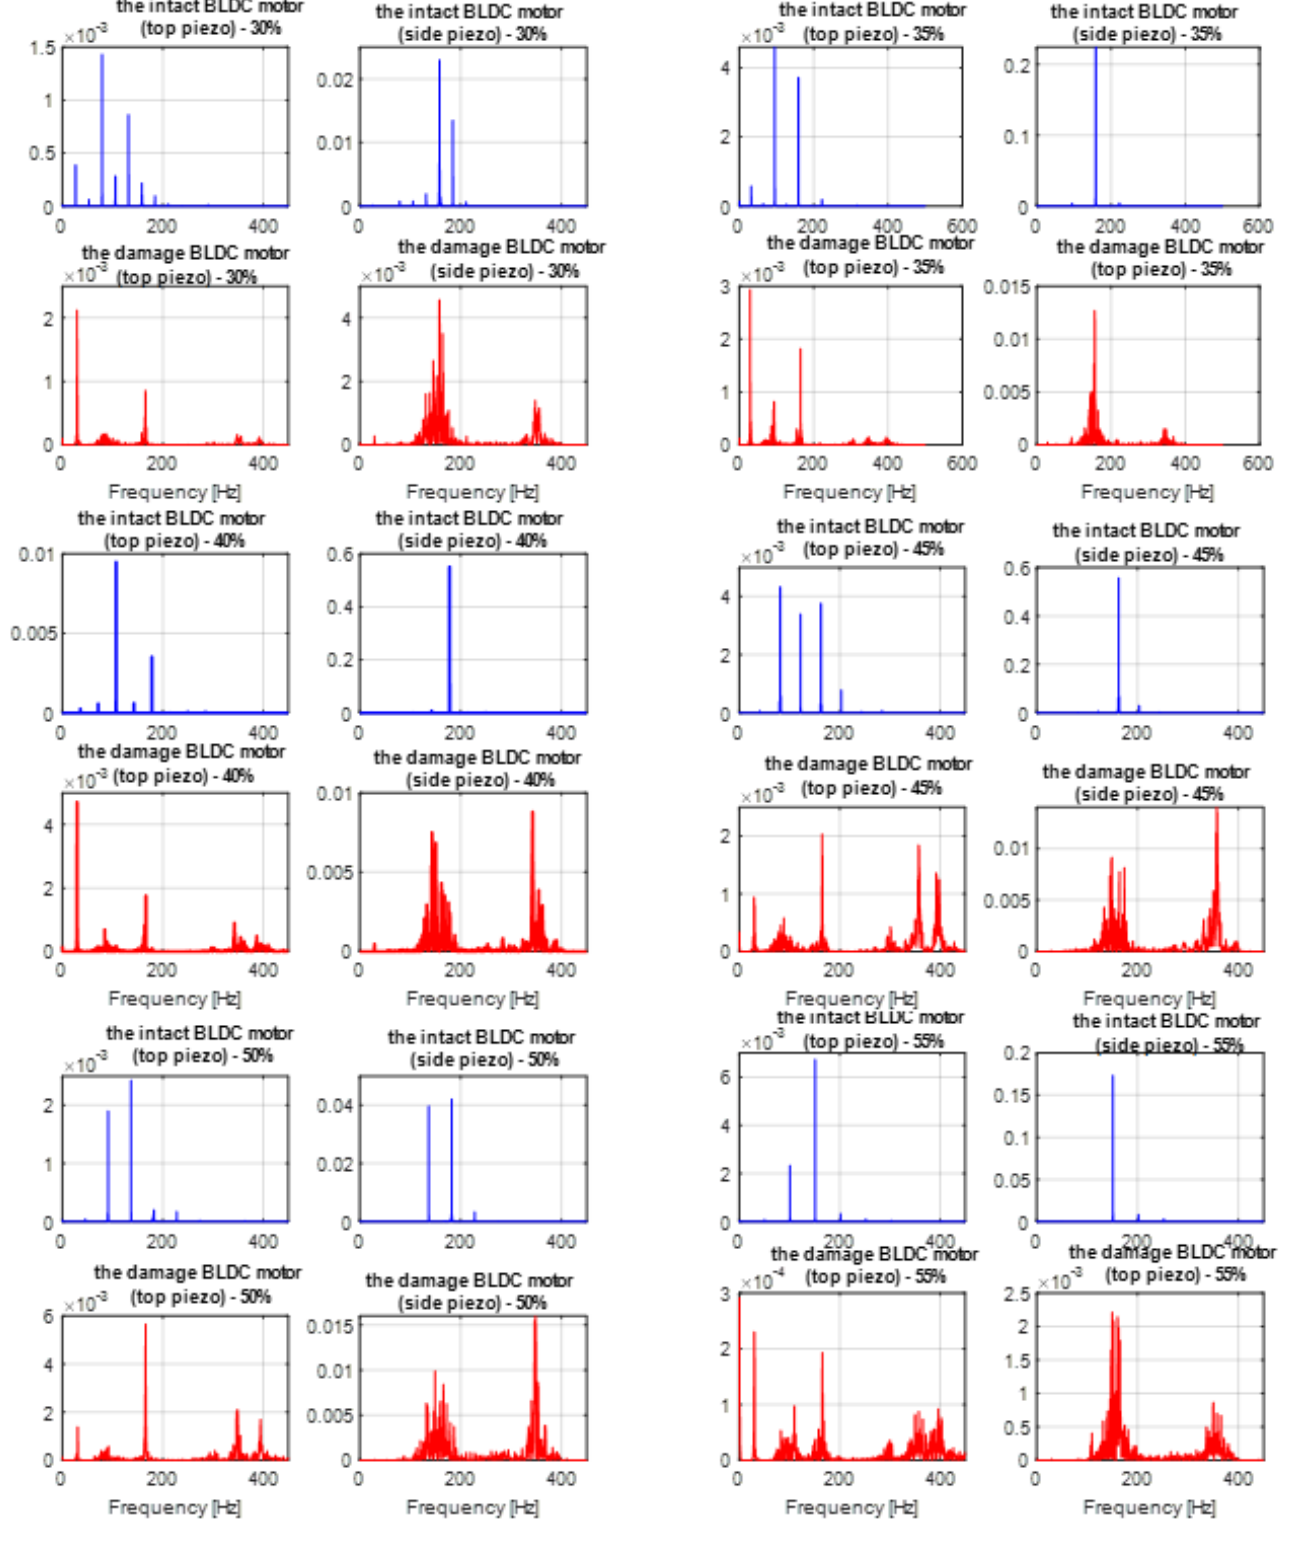
Figure 13. Frequency corresponding to voltage time series in Figure 12 for different values of the duty cycle of PWM signal applying to the BLDC